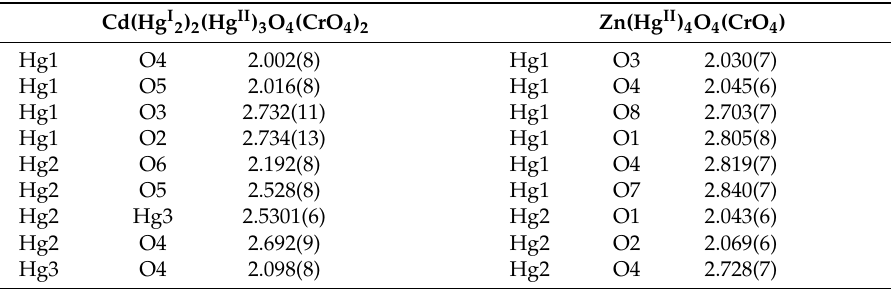
Table 1. Selected bond lengths (Å) and angles ( ◦